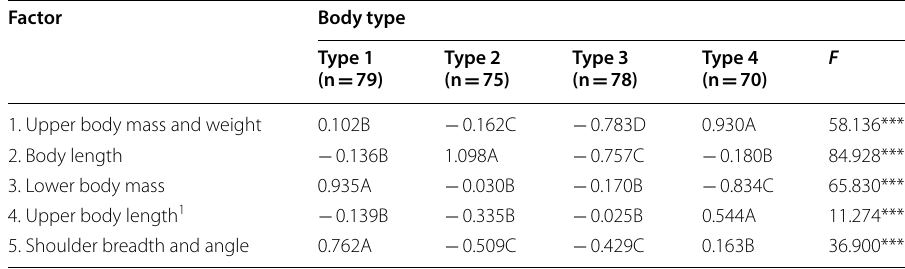
Table 5 Comparison of factor scores between body types (n